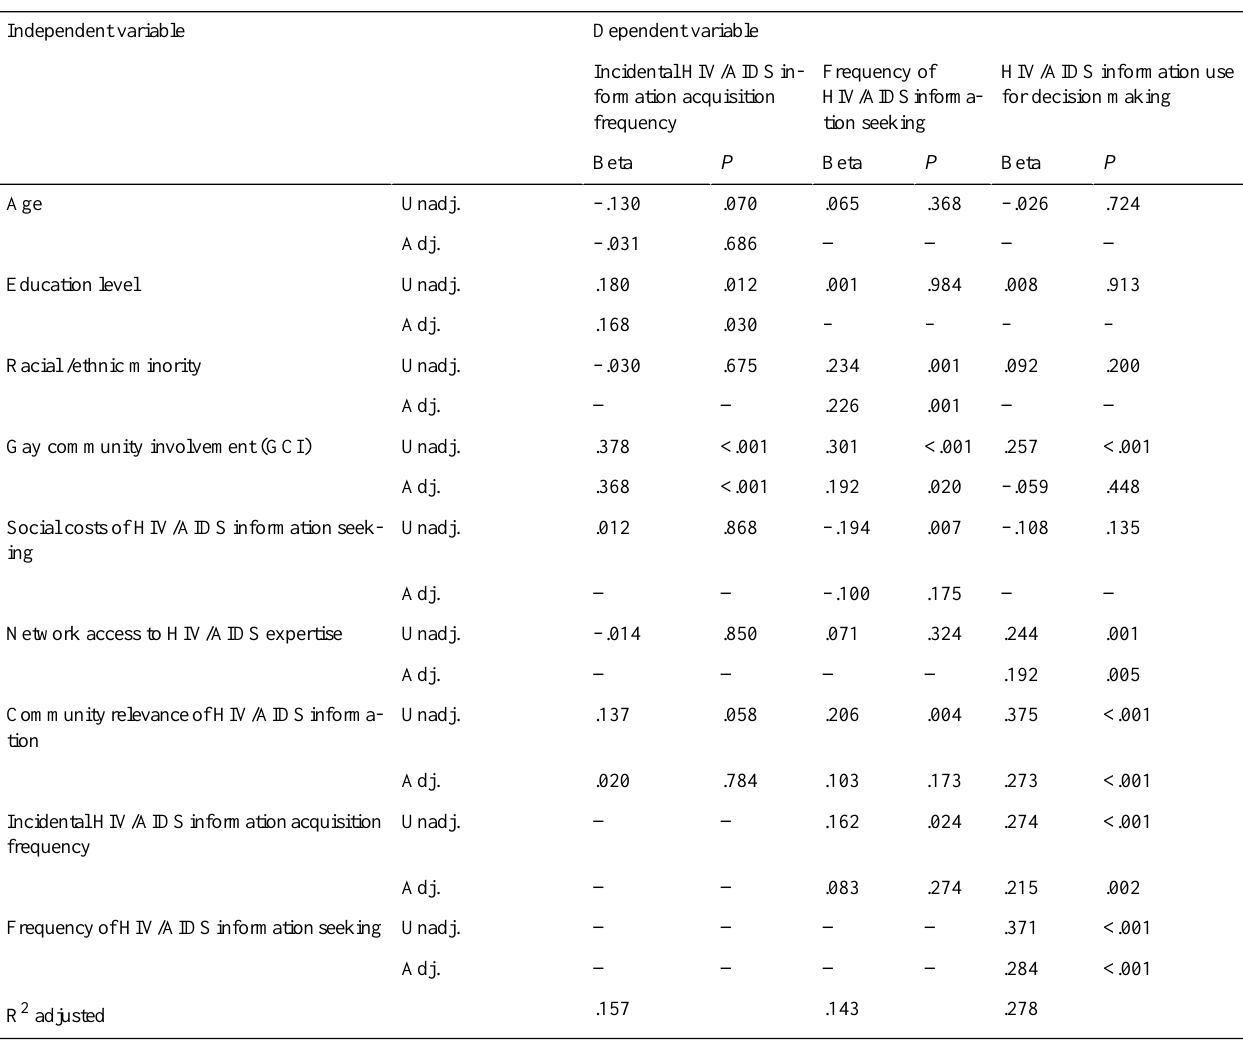
Table 5. Linear regressions for information interaction